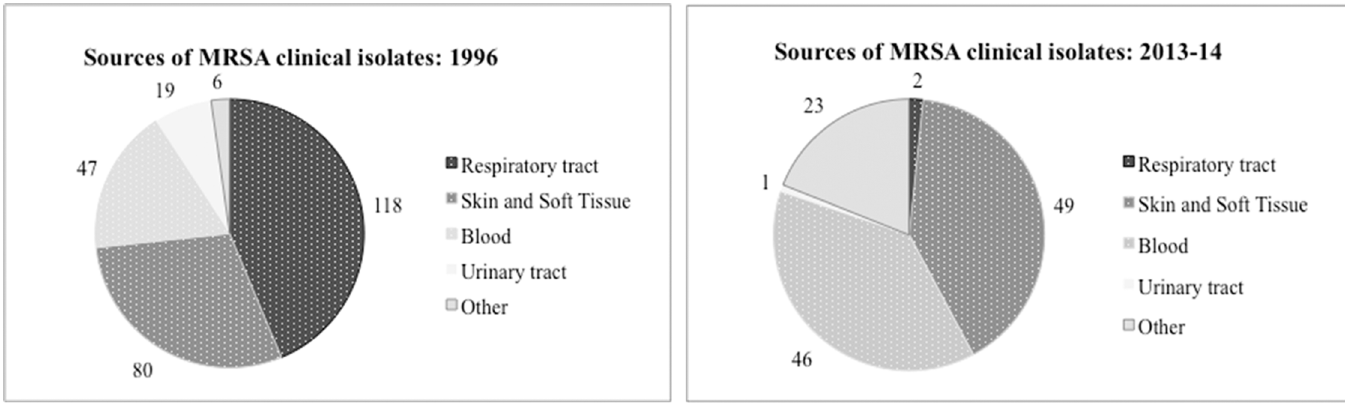
Fig 2. Change in the clinical sources of MRSA from 1996 to 2014. ‘ Respiratory tract ’ : lower respiratory tract (including sputum and bronch-alveolar lavage) and sinusitis and pleural fluid. ‘ Other ’ : any other biological specimen from which MRSA was isolated at any of the hospitals including the urinary tract, cerebro-spinal fluid, synovial fluid, placental biopsy and unlisted